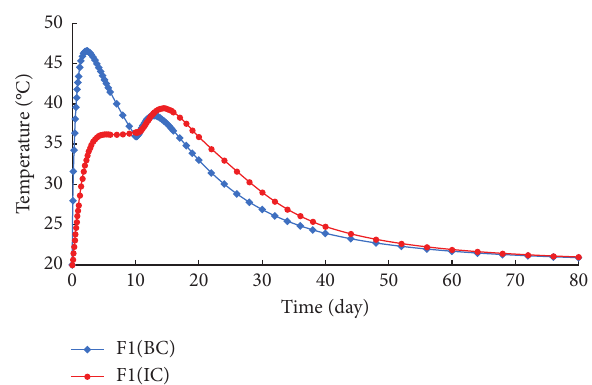
Figure 12: Temperature duration curve of key points F1 and F2 of sluice